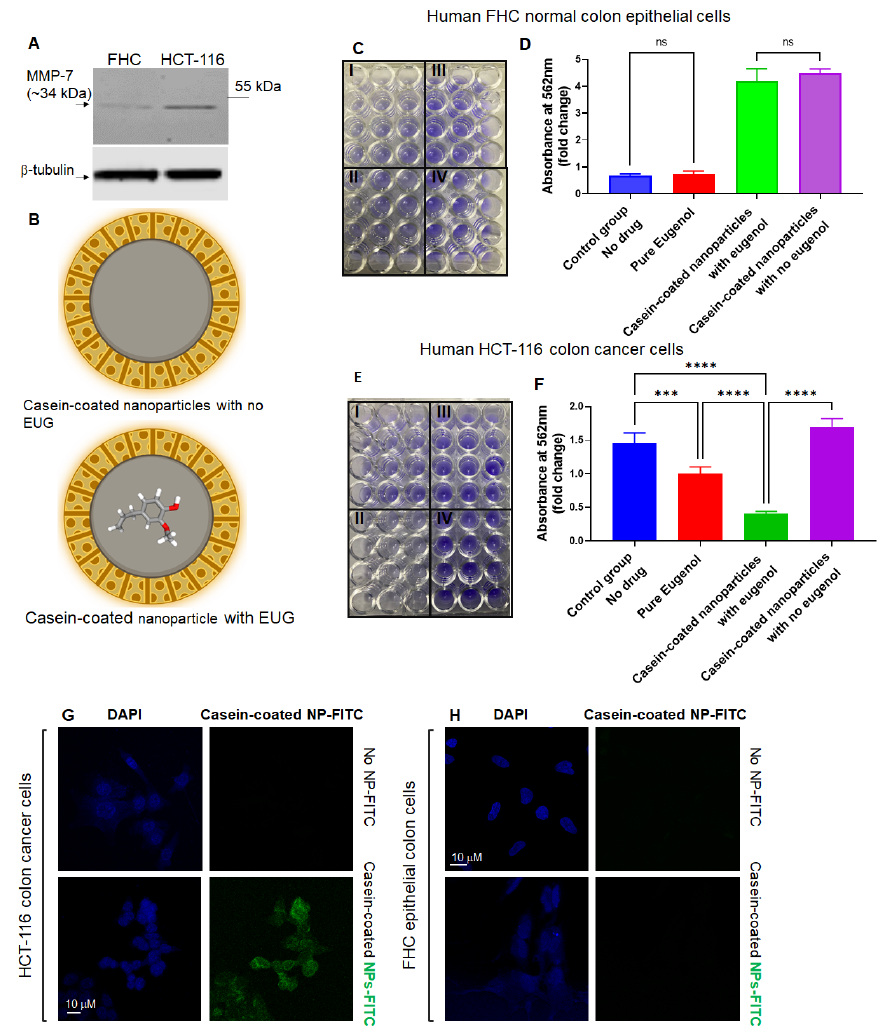
Figure 10. EUG delivered by casein-coated NP decreases cell viability in HCT-116 cells while